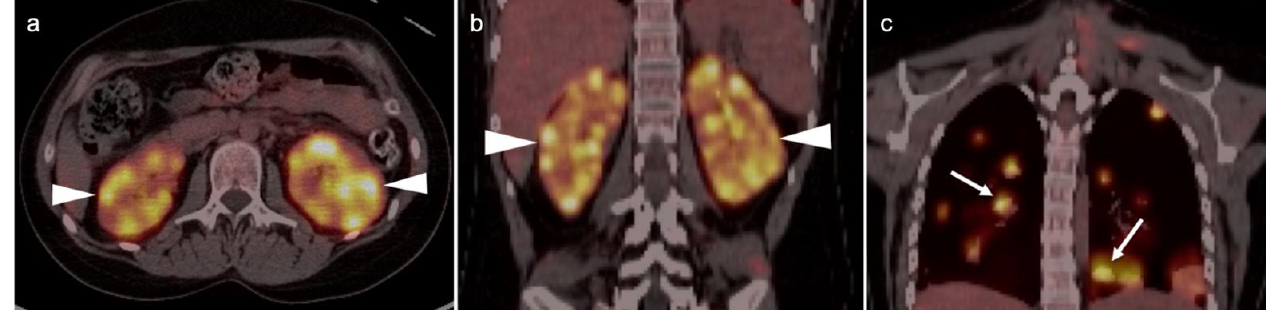
Figure 48. Sarcomatoid cell carcinoma on FDG PET-CT. ( c ) A large, hypermetabolic invasive mass arising from the left kidney extends into the pararenal space (white arrowhead); ( a , b ) The hyper- metabolic renal mass extends into the left pleural space, with an accompanying pleural effusion (white arrowheads). This was a sarcomatoid renal cell carcinoma, but the main differential would also include lymphoma.